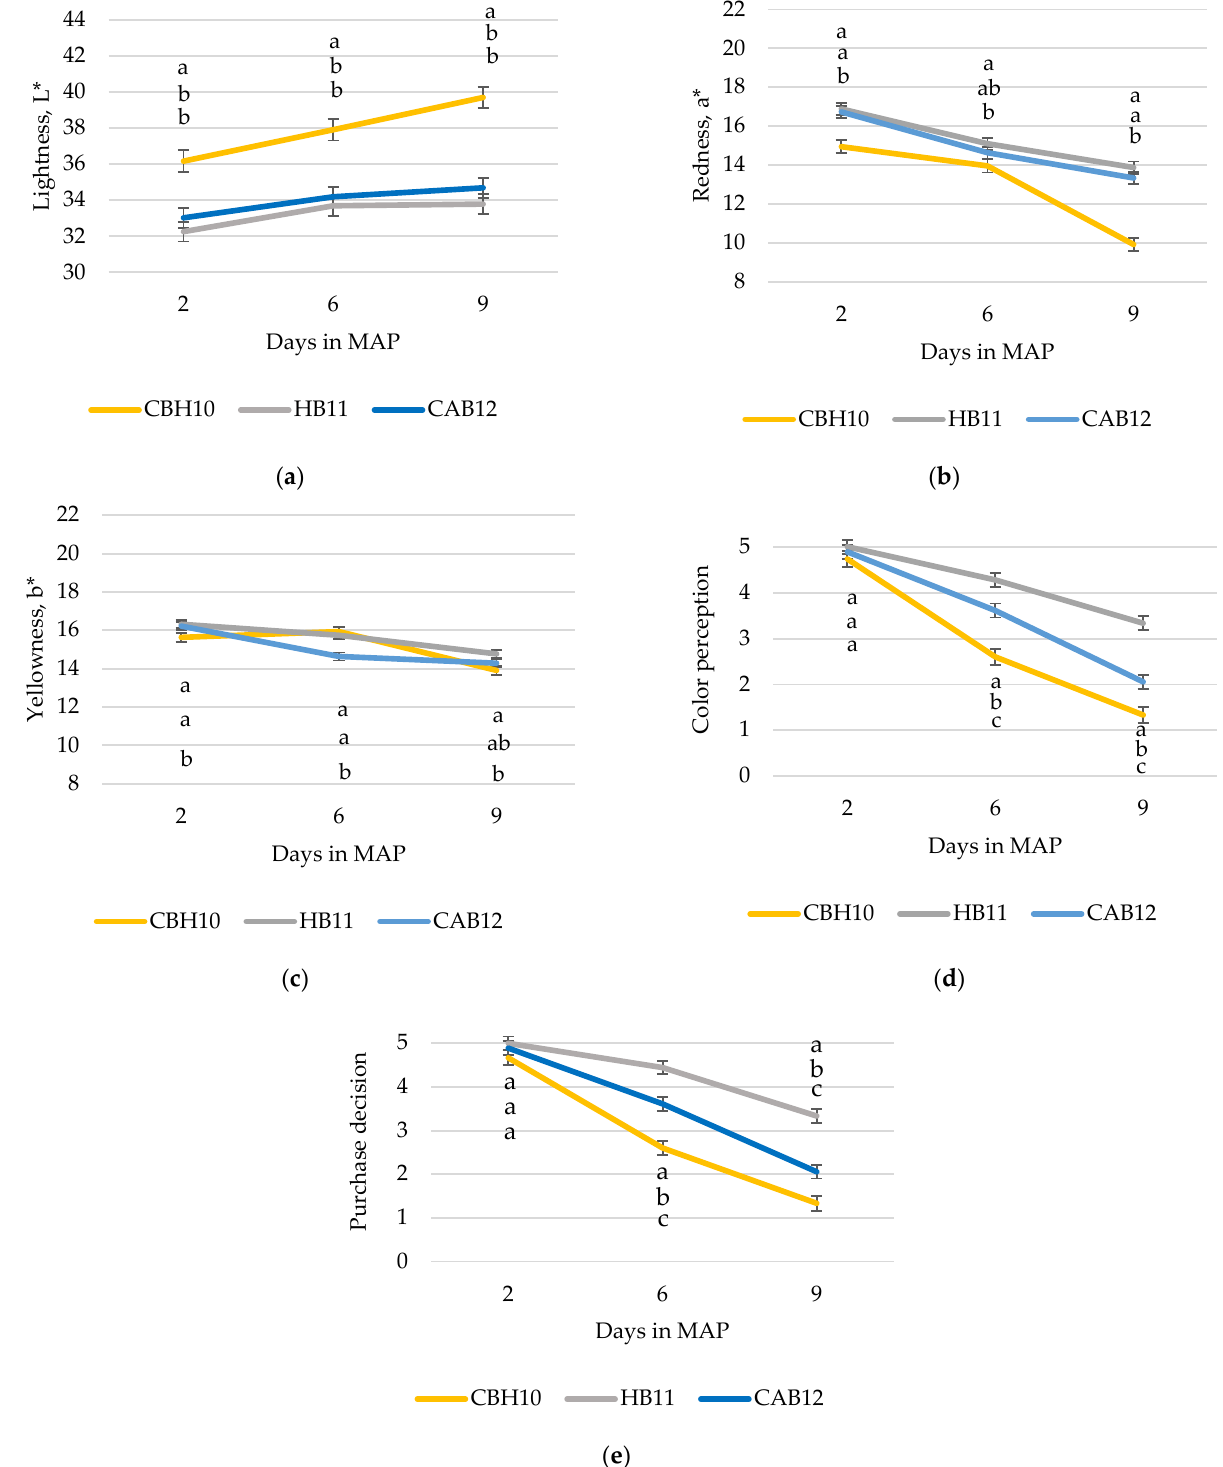
Figure 4. Evolution of the instrumental color (( a ) lightness, ( b ) redness, ( c ) yellowness)), ( d ) color perception (5-point scale: 1 = highly undesirable, 2 = moderately undesirable, 3 = slightly desirable, 4 = moderately desirable, and 5 = highly desirable), and ( e ) purchase decision (5-point scale: (1) would not buy, (2) would probably not buy, (3) buy dubiously, (4) would probably buy, (5) would buy) of meat over the storage time in refrigeration and MAP conditions by production system (crossbred Holstein x beef breeds such as Charolais or Limousine heifers, slaughtered at 10 months of age (CBH10); Holstein bulls, slaughtered at 11 months of age (HB11); and crossbred Holstein with Angus bulls, slaughtered at 12 months of age (CAB12)) ( a,b,c significant differences ( p < 0.05) between production system within the same day).